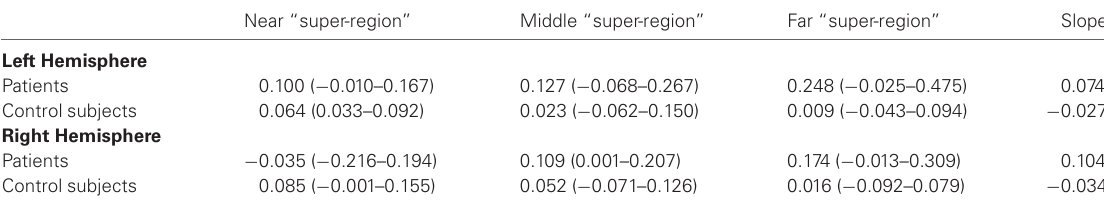
Table 1 | Mean percent signal change and its range (in brackets) for each perilesional “super-region” and the slope of the percent signal change as a function of distance from the lesion border